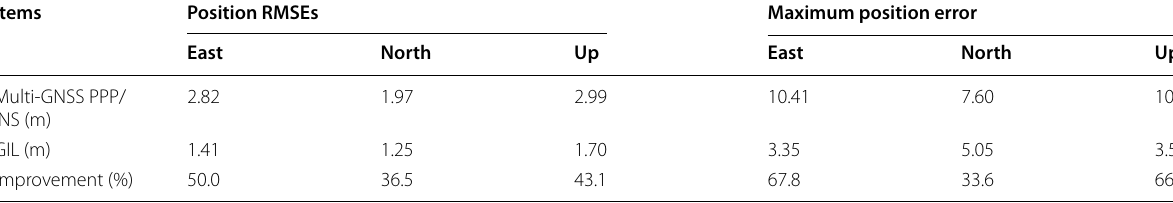
Table 7 RMSEs and maximum error of position for PPP/INS and GIL solutions in GNSS difficult experiment Items